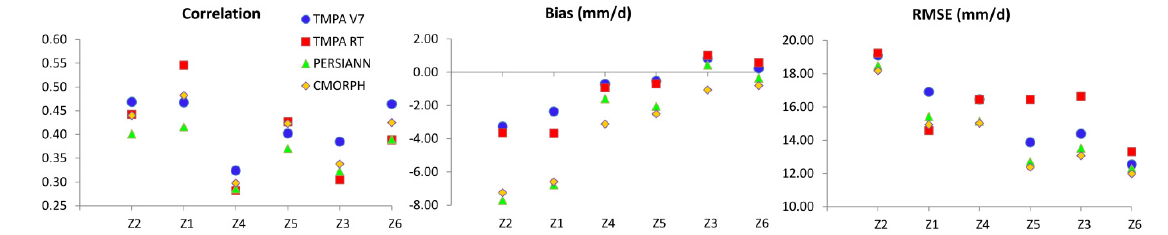
Figure 7. Correlation, bias (mm/d) and RMSE (mm/d) in each zone. Zones are ranked in descending order of annual accumulation.